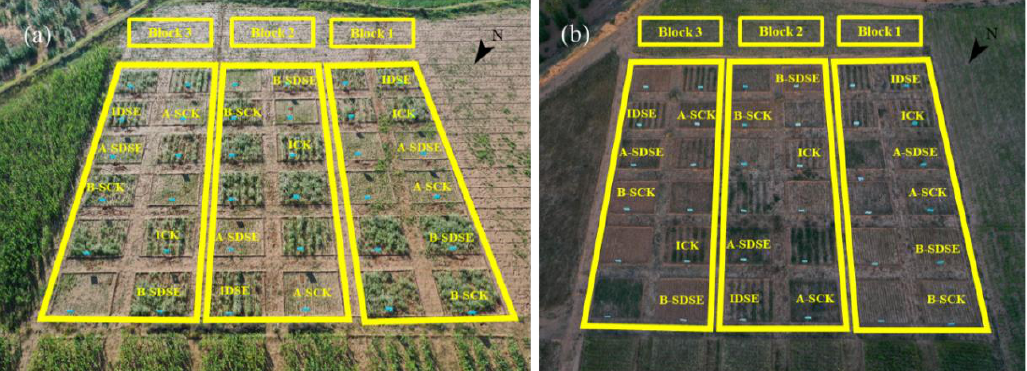
Figure 2. Field test layout in ( a ) 2020 and ( b ) 2021.